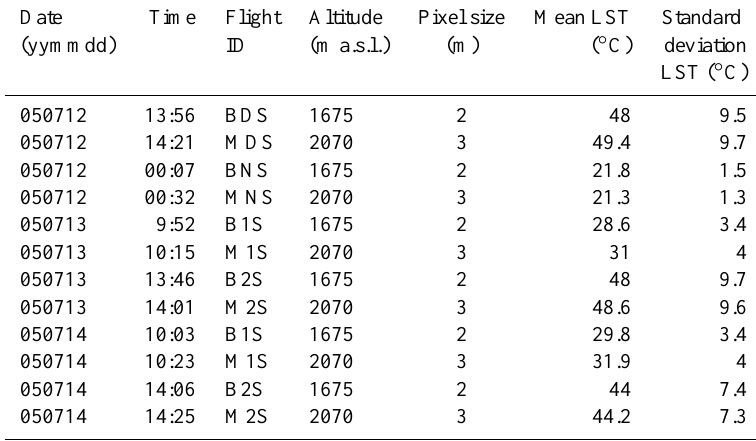
Table 1. LST computed from AHS